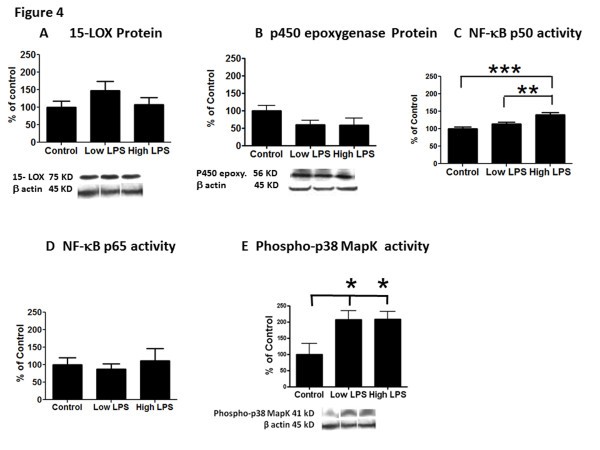
Protein levels of (A) 15-LOX, and (B) p450 epoxygenase (with representative immunoblots) in control, low- and high-dose LPS rat brain. Data are ratios of optical densities of protein to β-actin, expressed as percent of control and were compared using one-way ANOVA, mean ± SEM (n = 8). Representative brain transcription factor binding activities (DNA-protein complex) of (C) NF-κB p50 and (D) NF-κB p65 in control, low- and high-dose LPS rat brains. DNA binding activity was measured in brain nuclear extracts as described in Materials and Methods. Mean ± SEM (n = 8), **p < 0.01. Protein levels of (E) phospho-p38 MAPK (with representative immunoblots) in control, low- and high-dose LPS rat brain. Data are ratios of optical densities of protein to β-actin, expressed as percent of control. Comparisons between LPS groups were made using one-way ANOVA, mean ± SEM (n = 8), *p < 0.05.